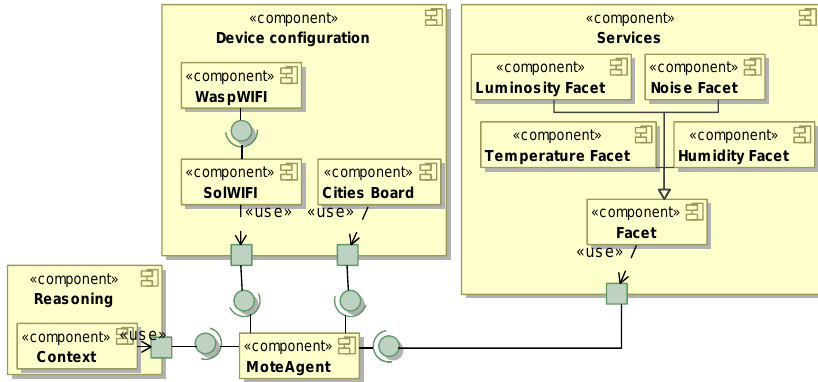
Figure 6. MoteAgent architecture configuration for the device configuration